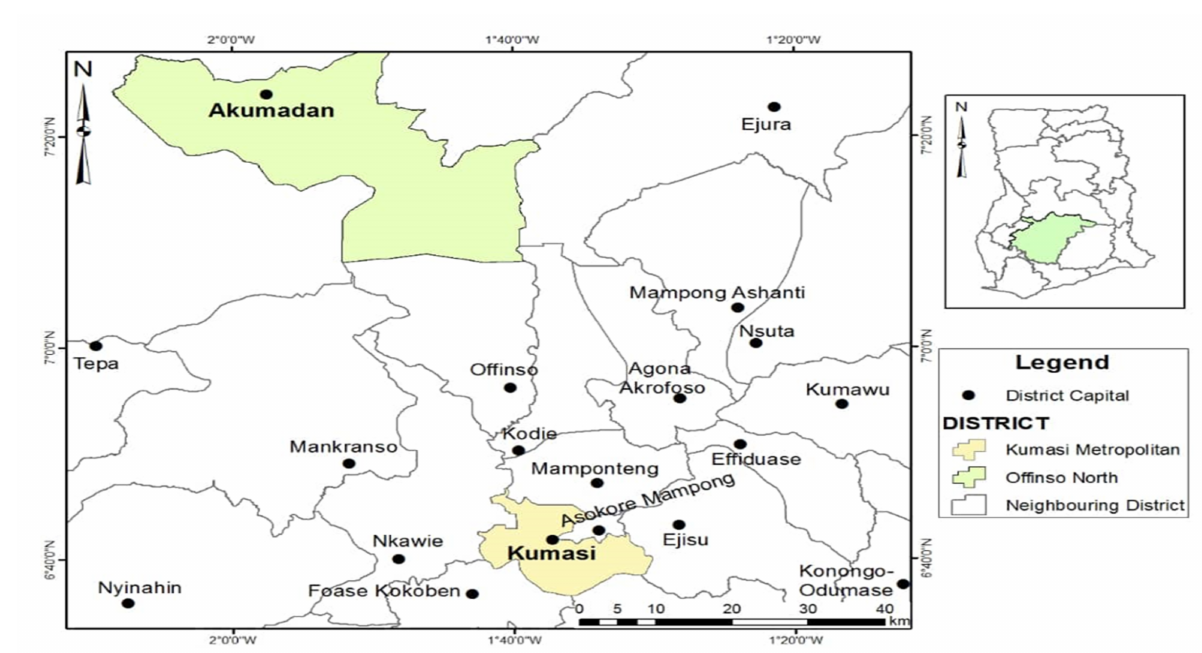
Figure 2. Map of Ashanti region showing the study sites (Kumasi metropolis and Offinso north district). Source: GIS unit of the Department of Geography and Regional Planning